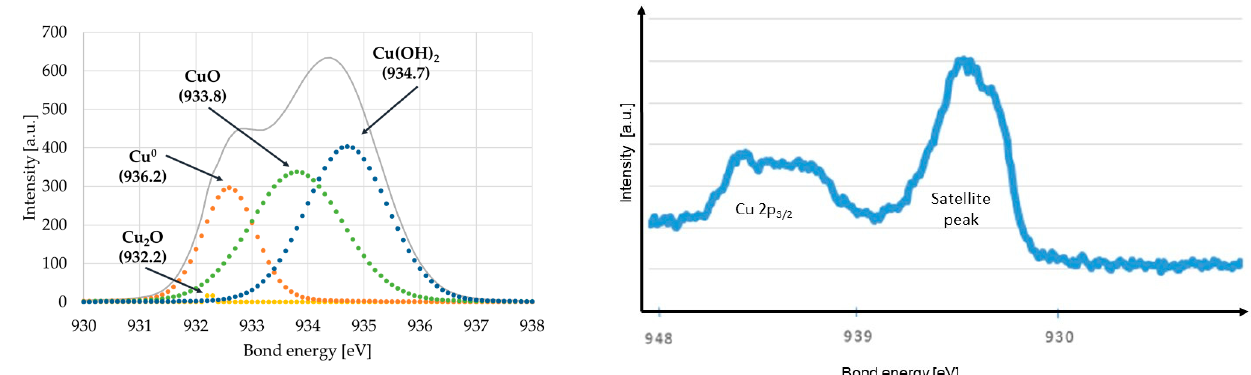
Figure 4. Curve fitting of Cu 2p 3/2 XPS spectra—example for Cu-DLC1 coating deposited on AISI 316LVM ( left ). The Cu 2p 3/2 peak and the satellite peak for Cu-DLC4 coating deposited on Ti6Al7Nb alloy ( right ).